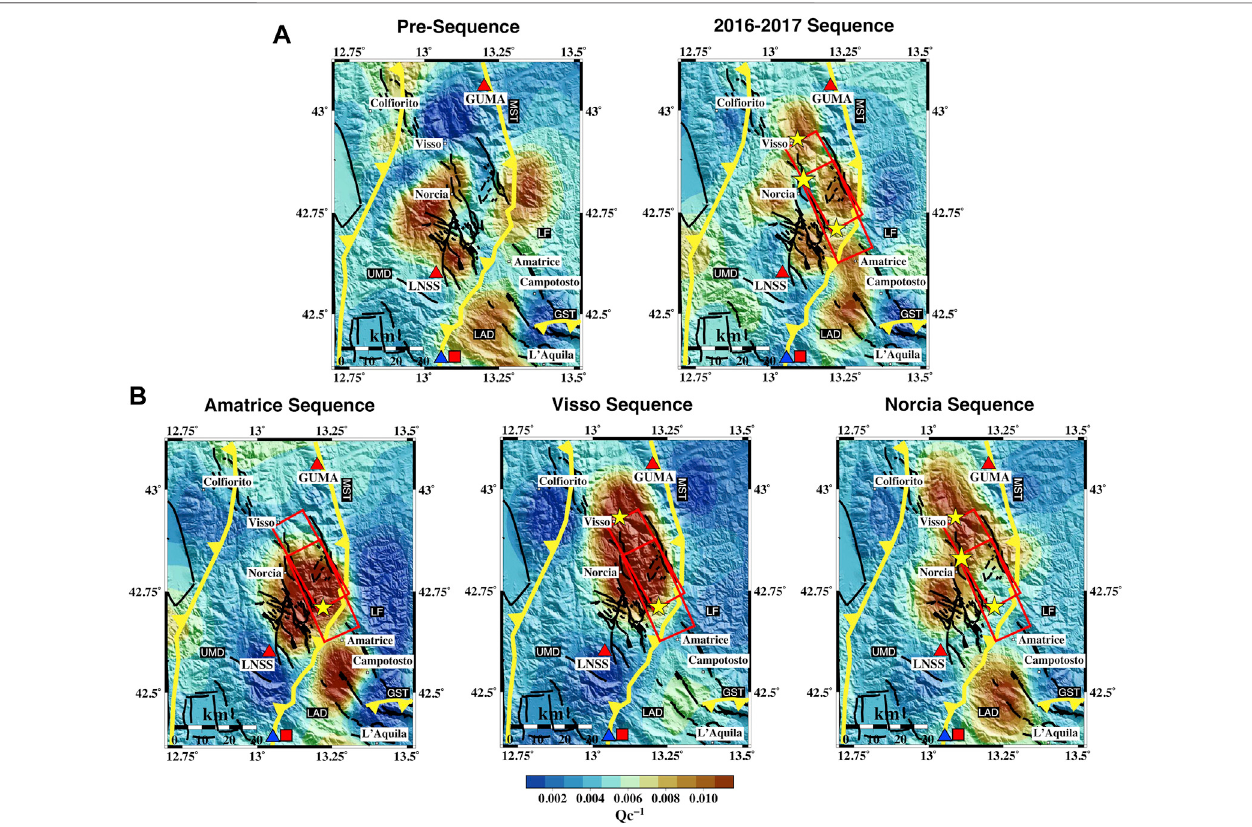
FIGURE 7 | Spatial variation of Q c − 1 at f c = 1.5 Hz for the (A) pre-sequence and 2016 – 2017 sequence and (B) three individual sequence time frames. Red boxes are the fault plane activated during the AVN, and the black lines are the fault lines from the ITHACA catalog. Yellow lines are the main thrust of the area. The main thrusts are highlighted: MST, Monti Sibillini thrust; GST, Gran Sasso thrust. The red square and the blue triangle are the Velino and Canetra springs ’ locations, respectively. The stars indicate the mainshocks of each 2016 – 2017 sequence. The maps have been restricted to the area of interest covered by the checkerboard tests.